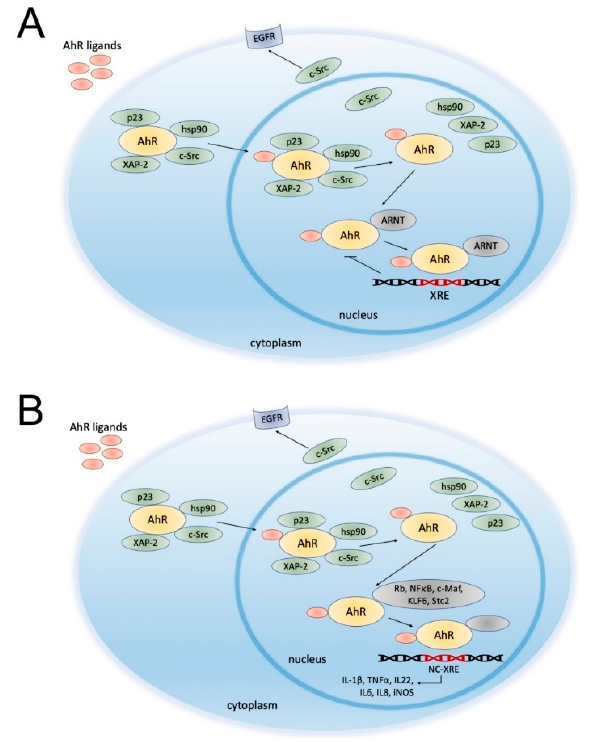
Figure 1. Schematic overview of aryl hydrocarbon receptor (AhR) signaling pathways: canonical ( A ) and noncanonical ( B ). In physiological conditions, AhR is localized in the cytosol and complexed with specific proteins, such as the hepatitis B virus X-associated protein 2 (XAP-2), heat shock protein 90 (HSP90), c-Src and p23. Upon ligand binding, AhR changes its conformation and is translocated to the nucleus, where it dimerizes with AhR nuclear transporter (ARNT) ( A ) or other partners, such as transcription factors (e.g., Kruppel-like factor 6 (KLF6)). ( B ). Dissociated c-Src interacts with the epidermal growth factor receptor (EGFR). To date, several different types of crosstalk between AhR and other proteins have been